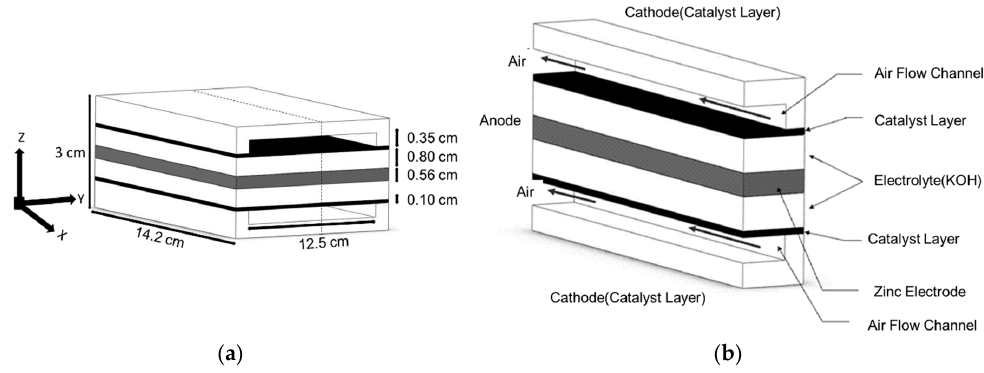
Figure 1. Schematic representation of a single Zn–air fuel cell. ( a ) Single cell with rectangular shaped channels and ( b ) flow channels geometry.